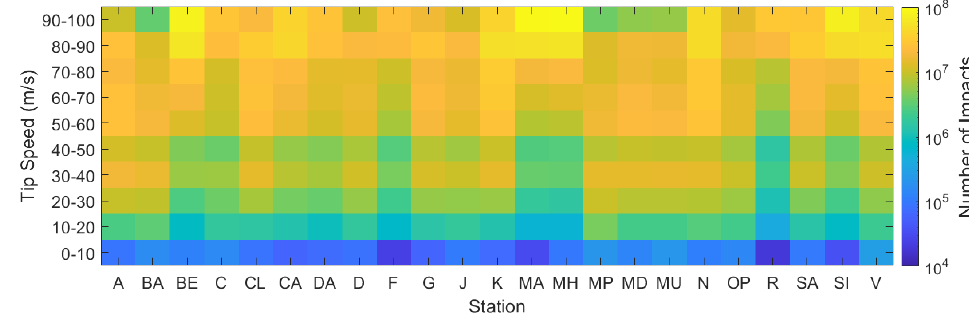
Figure 8. n A at each site for each impact speed bin, as calculated. Even stations, such as BA and MP, with relatively few hours at rated speed still managed to receive ∼ 10 6 impacts (Figures 8 and 9). N had the most rain hours of all stations with 2375 h. However, surprisingly MH had the highest E K , A ( ∼ 670 kJ) with only 1768 h.